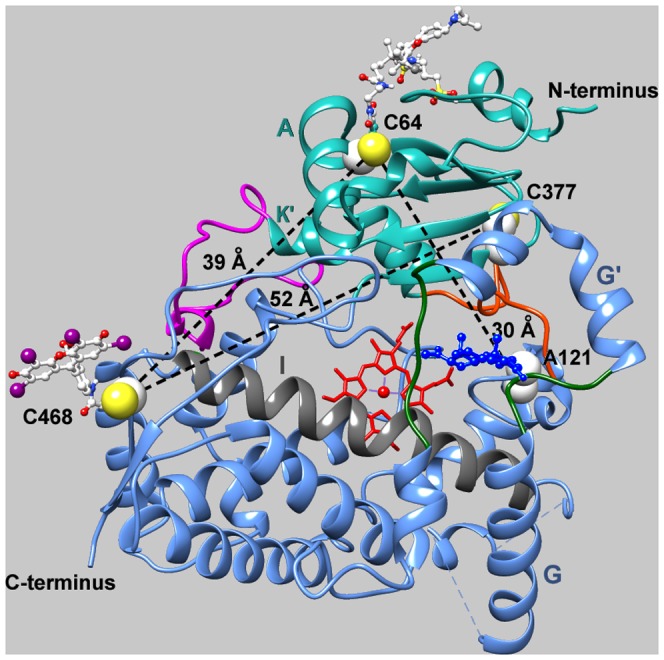
Position of the points of attachment of thiol-reactive probes used in this study.The cartoon representation of the structure of CYP3A4 is based on the coordinates of the enzyme complex with peripherally-bound progesterone (PDB 1W0F). Side chains of the cysteine residues C64, C377 and C468, as well as the alanine residue C121 (which we replaced with cysteine in our C64/C121 mutant) are shown in spheres. The structures of ERIA and DYM attached to residues Cys468 and Cys64 are shown in ball-and-stick representation. The part of the protein referred to here as the beta-domain is shown in sea green, while the alpha-domain is represented in blue (except for a-helix I, which is shown dark gray). The loops shown in magenta and orange are the meander loop and the B/B′ loop, respectively. The G/G′ and F/F′ loops, which surround the peripherally-bound molecule of progesterone (not shown), are shown in green. The molecule of progesterone bound in the proximity of the B/B′, F/F′ loops is shown as a dark-blue ball-and-stick model.